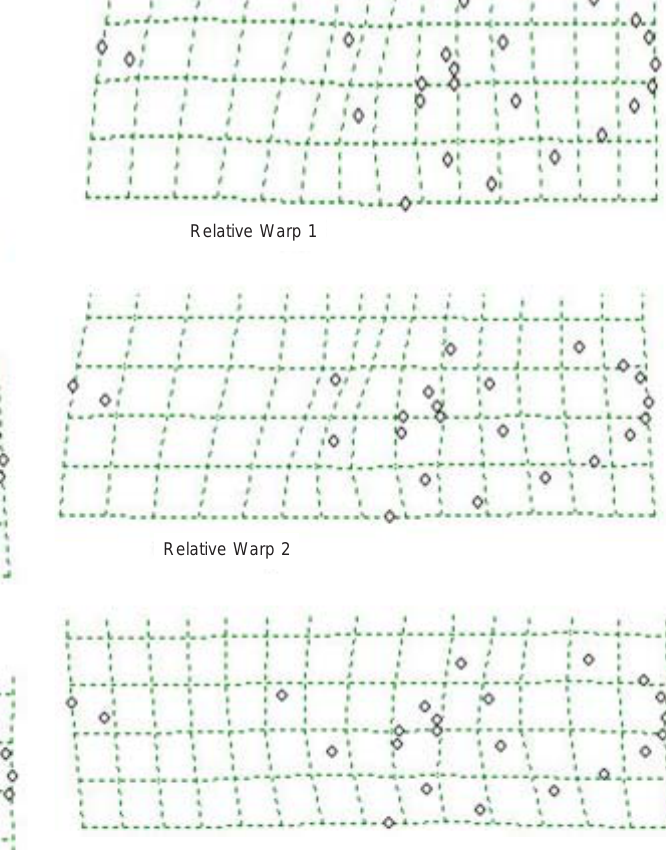
Figure 1. Culex quinquefasciatus A) Female, B) Male